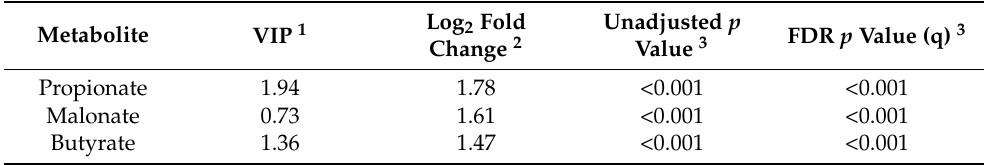
Table 3. Significant ( p ≤ 0.05) associations between relative concentrations of metabolites and feeding